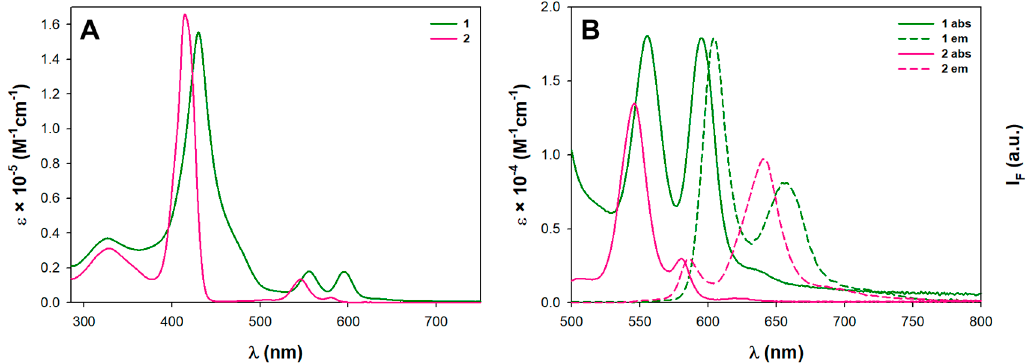
Figure 2. ( A ) Full UV-vis absorption spectra of 1 and 2 recorded in toluene solution; ( B ) spectra of the Q bands and normalized emission spectra recorded in toluene solution at 10 − 6 M concentration.